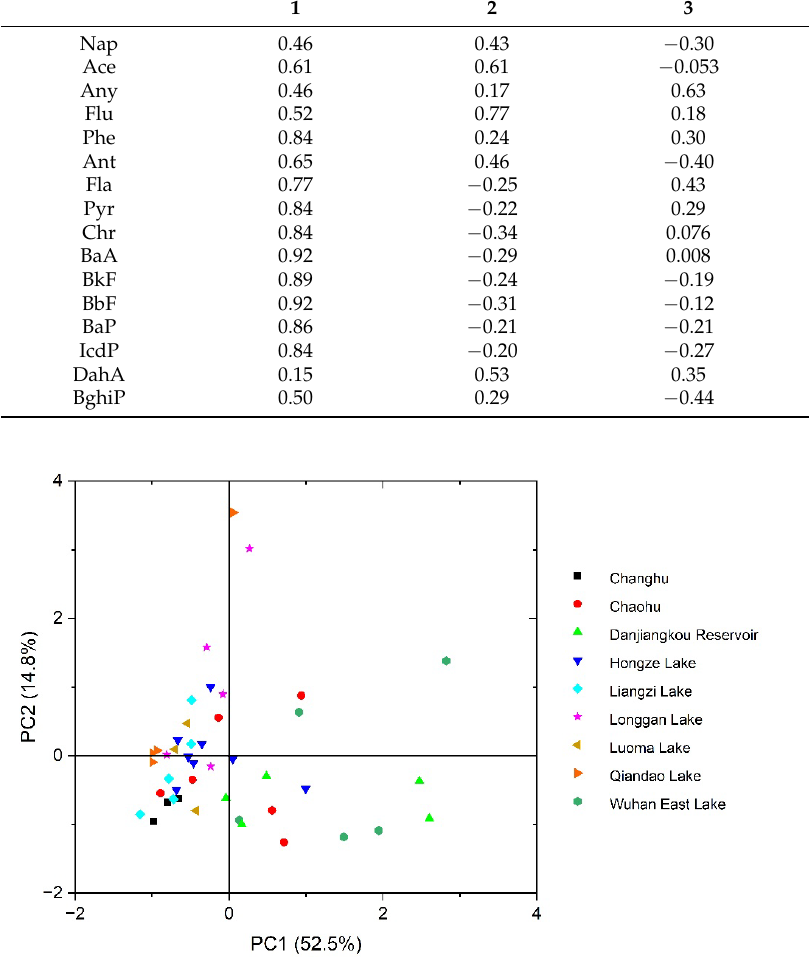
Figure 9. Scores of principal component 1 (PC 1) and principal component 2 (PC 2) for plants near different lakes.